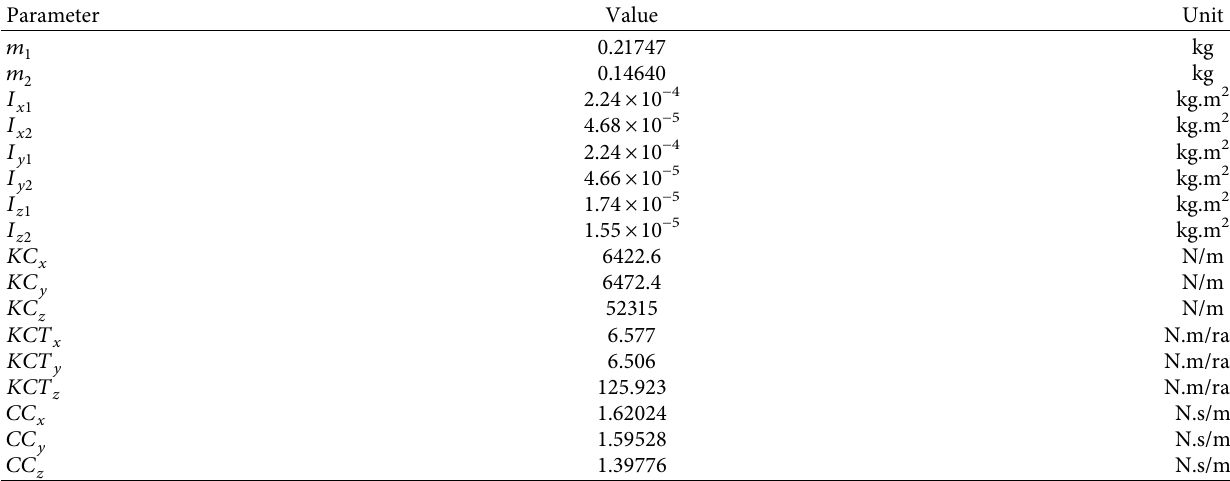
Table 6: Physical parameters of the black flexible